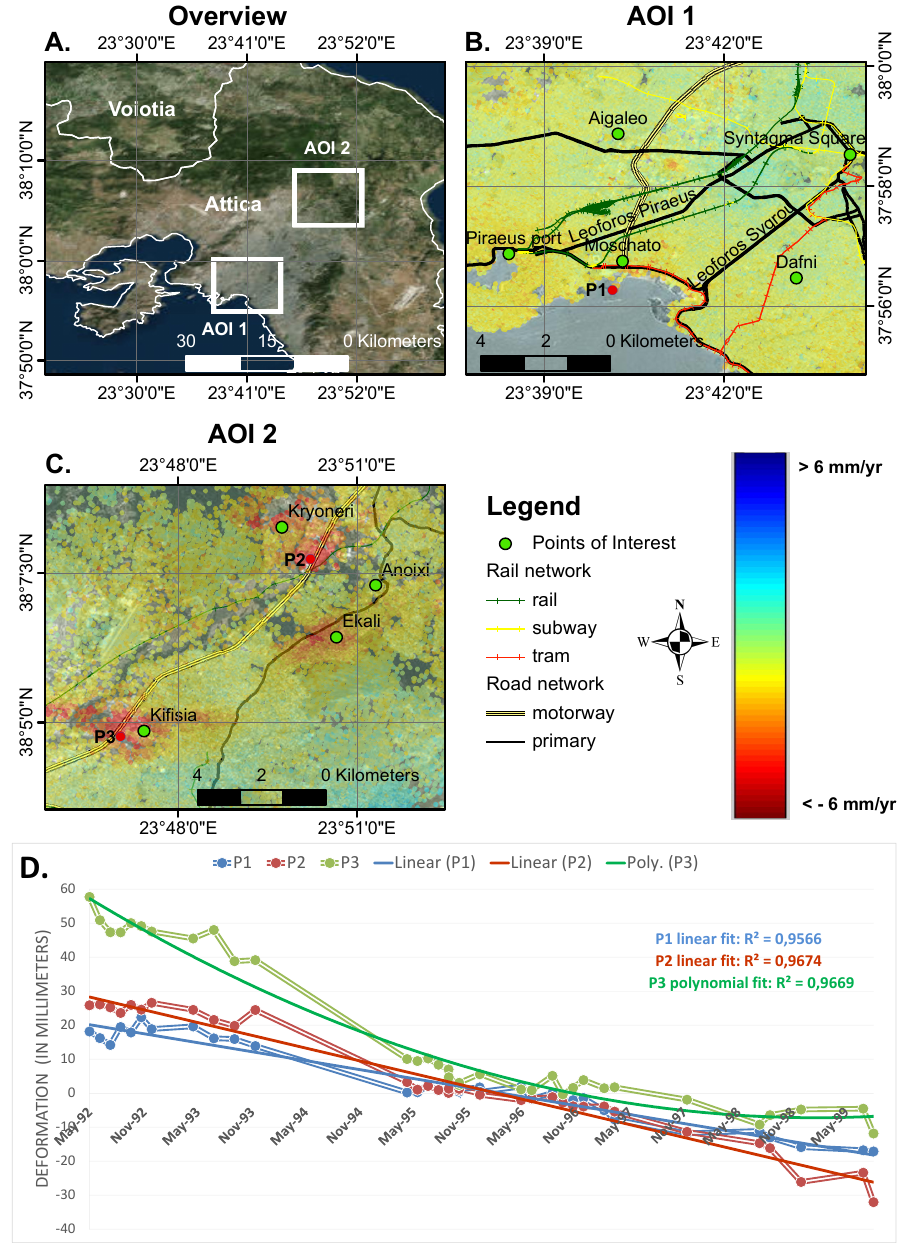
Figure 5. Zoom in selected AOIs (Areas of Interest) for the 1992–1999 time series analysis. ( A ) Overview of the study area and selected AOIs; ( B ) the velocity field for AOI1, in the wider region around the city of Piraeus; ( C ) AOI2 in the northern suburbs of Kifisia, Ekali and Kryoneri. For both AOIs, local displacement patterns emerge and are mapped in great detail. For the selected scatterers P1, P2 and P3, ( D ) shows their deformation histories. A linear velocity model is fit to P1 and P2, linear (P1) and linear (P2) correspondingly, while a second degree polynomial model, Poly.(P3), fits better the data for P3. The latter is an indication that the region of Kifisia has been experiencing non-linear